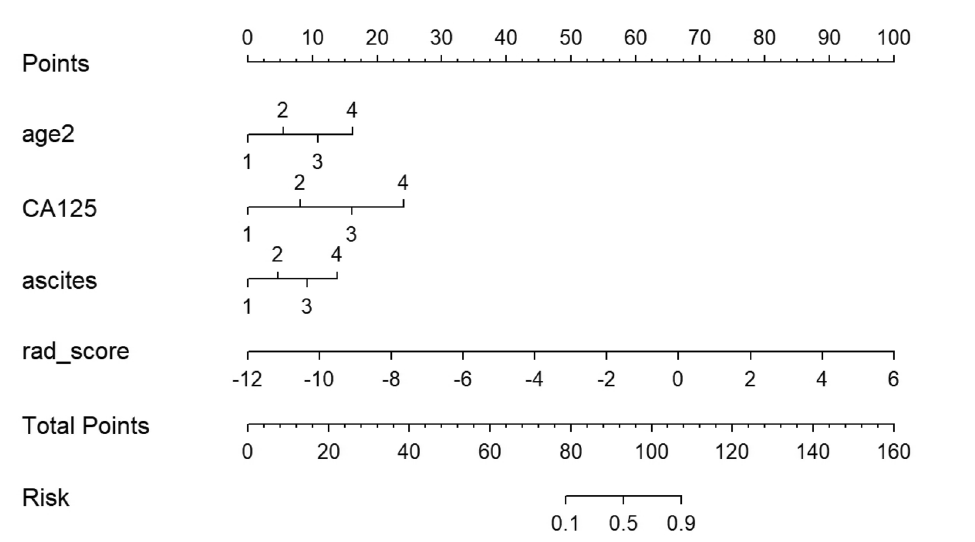
Figure 4. A nomogram for identifying benign and malignant ovarian